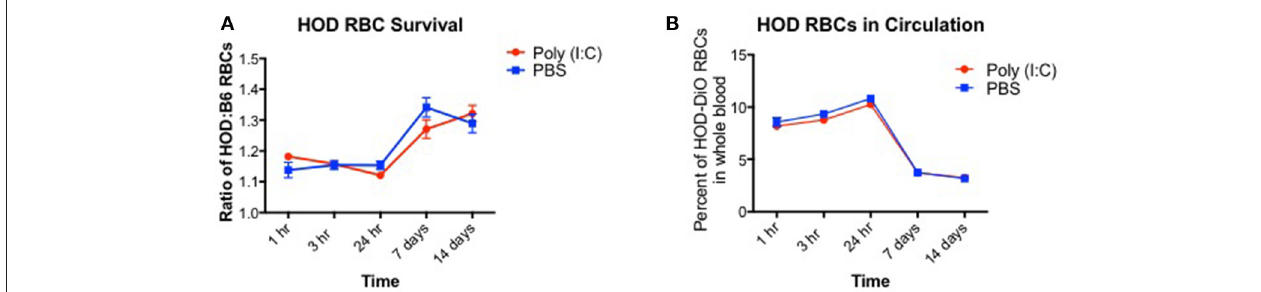
FIGURE 2 | RBC clearance rates are similar between baseline and inflamed conditions. Recipient B6 mice were treated with 200 ug of poly (I:C) or control PBS and subsequently transfused with a 100 uL of 1:1 mixture of DiI + B6 and DiO + HOD RBCs. Whole blood was collected at multiple time points and (A) the ratio of DiO +